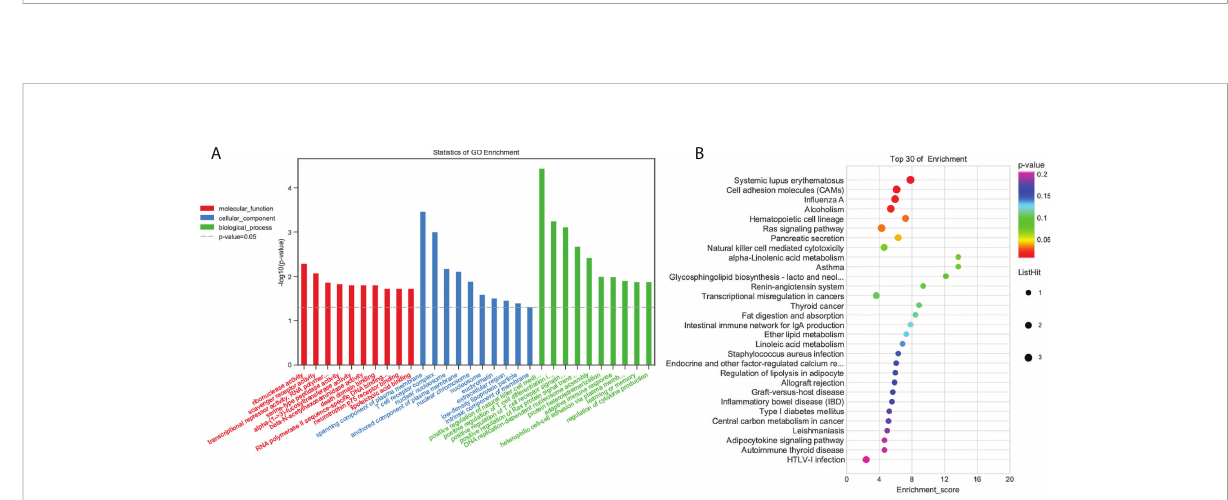
FIGURE 4 Functional enrichment analysis of DEGs. (A) GO enrichment. BP: Biological process. CC, Cellular component; MF, Molecular function. (B) KEGG pathway DEG enrichment scatter plot.